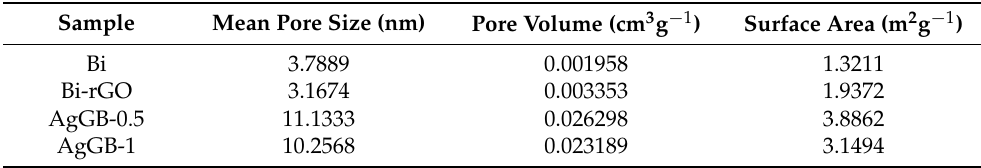
Figure 7. ( a ) Photocatalytic performance of AgGB composite for the degradation of RhB as measured by UV-vis DRS; ( b ) Degradation of RhB over different catalysts under visible light irradiation; ( c ) Photo-catalytic reaction with linear fitting modes and the reaction rate constant k. Table 1. Characteristics obtained from nitrogen desorption